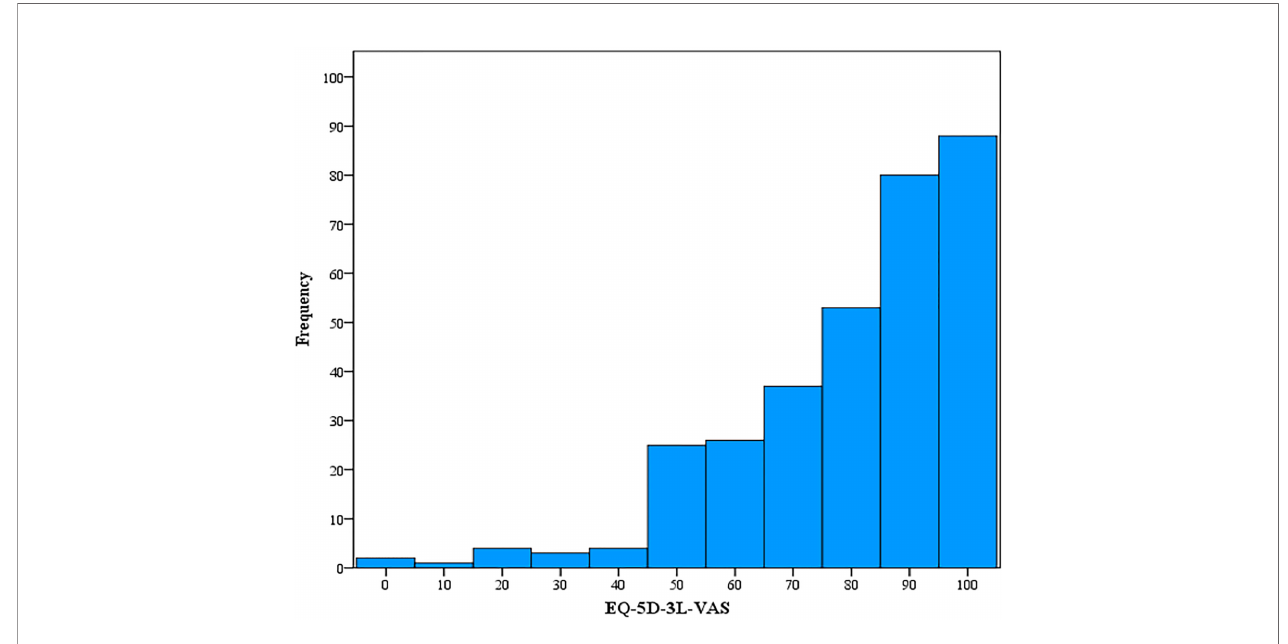
FIGURE 2 | EQ-5D-3L VAS Frequency